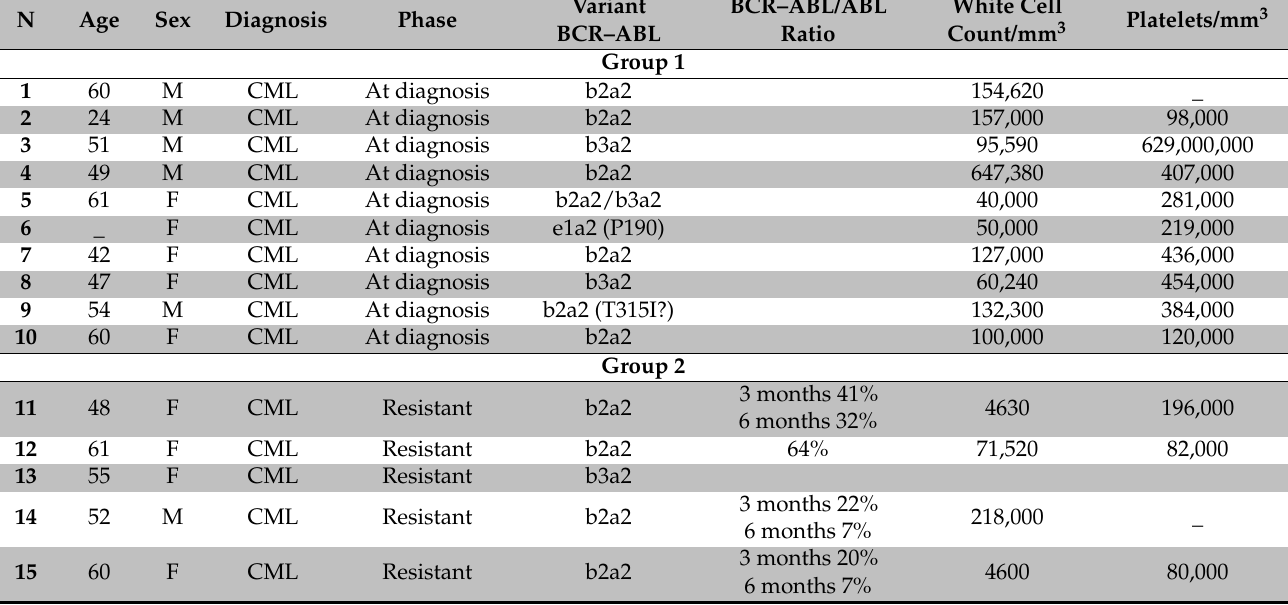
Table 1. Clinical features of the CML